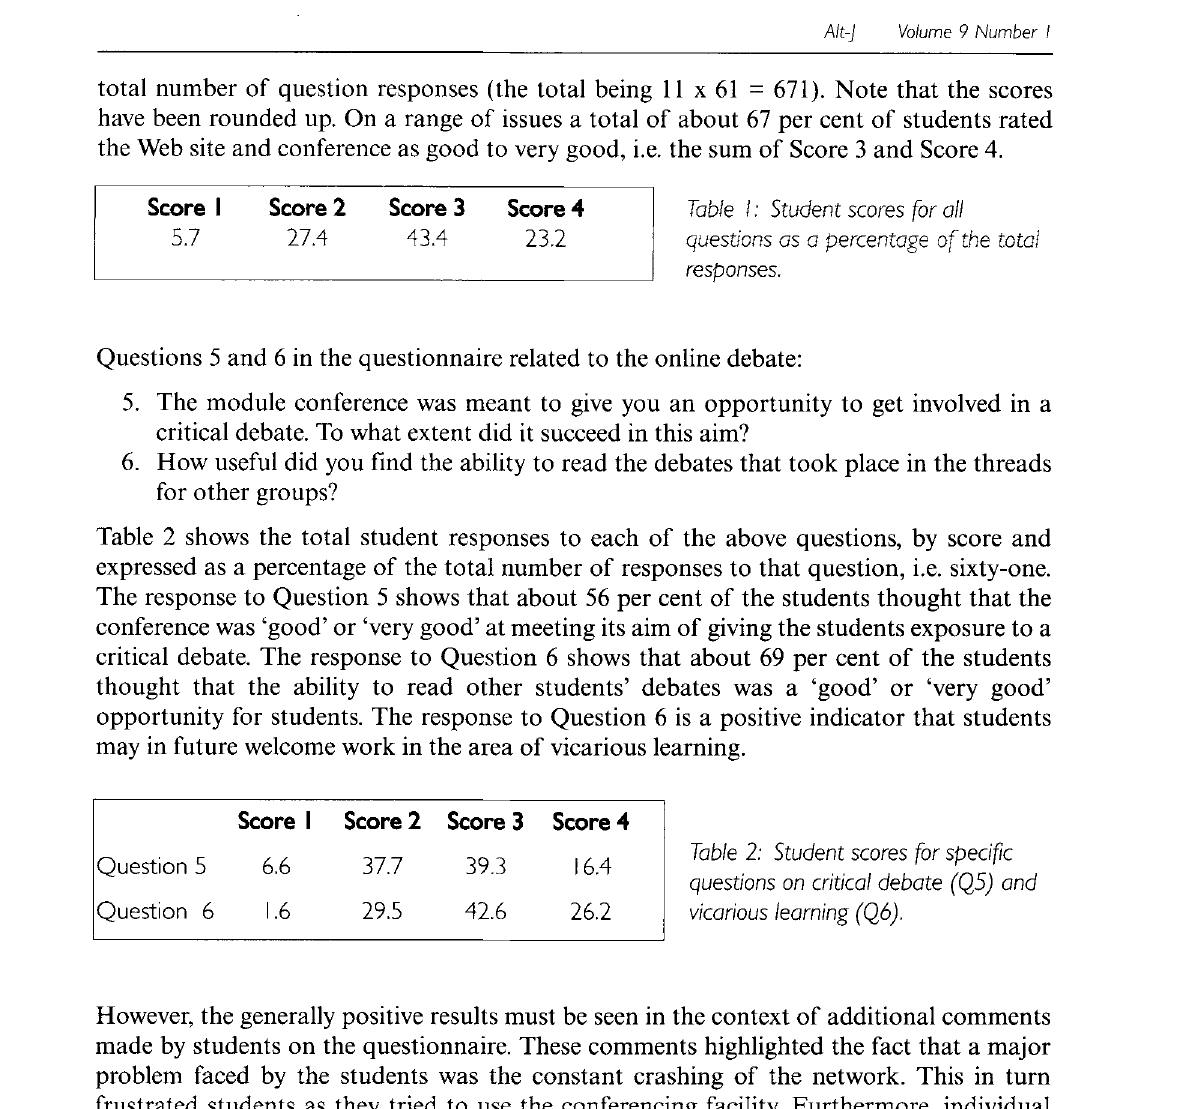
Table 1: Student scores for all questions as a percentage of the total responses,